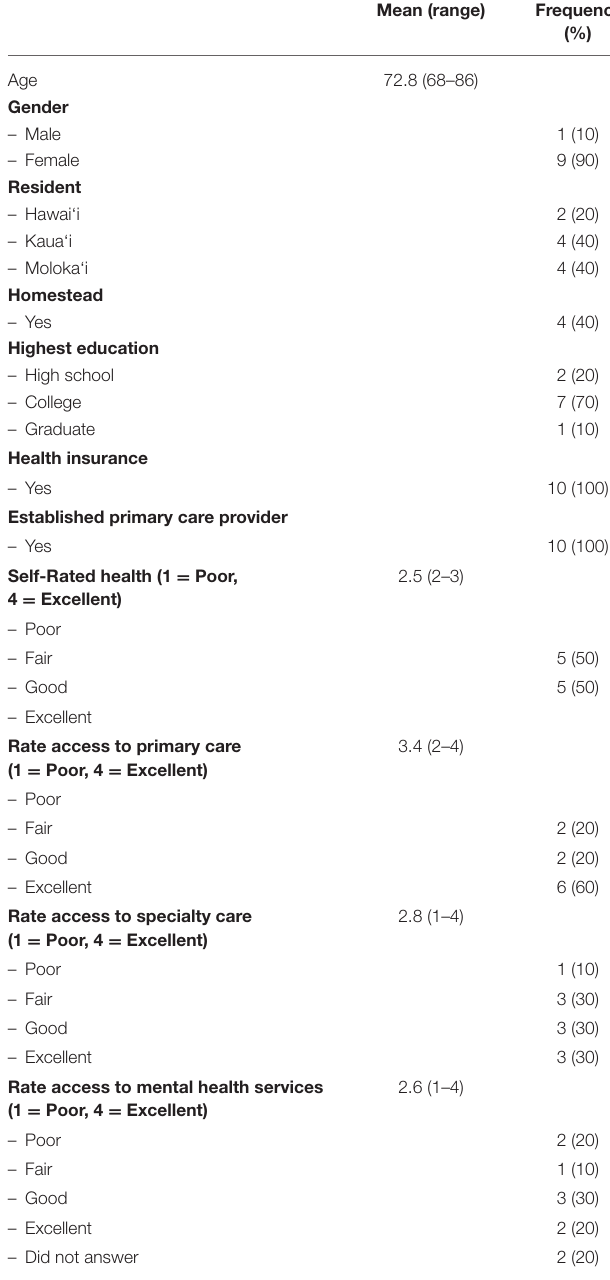
TABLE 2 | Participant characteristics ( n =